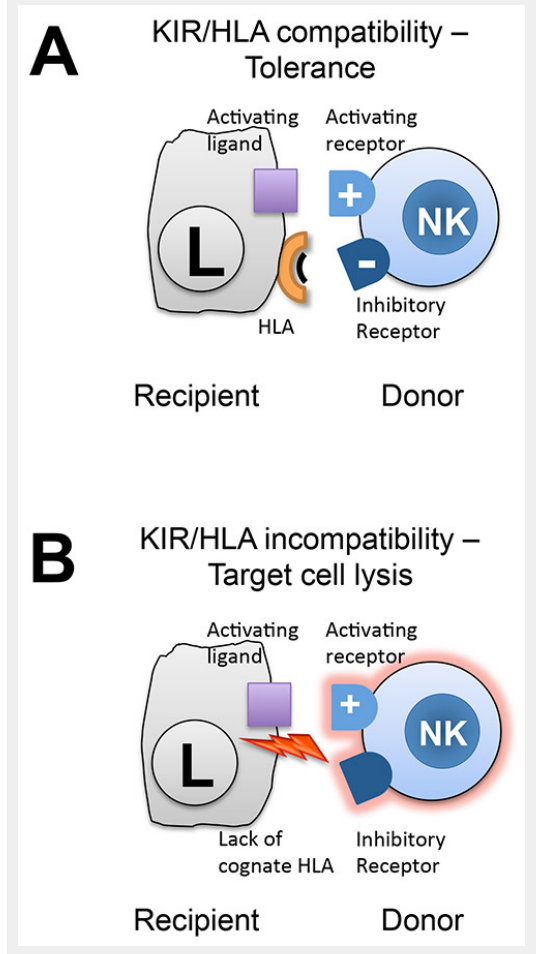
NK cell alloreactivity after haploidentical stem cell transplantation is determined by the HLA class I antigen/KIR constellation of donor and recipient. Donor NK cell activating and inhibitory receptors interact with ligands on recipient target (leukaemia) cells. The activation state of NK cells is determined by the integration of both types of signals. In the case of KIR/HLA compatibility, the inhibitory signal dominates and induces tolerance (panel A). In the absence of a cognate HLA ligand, activating signals dominate and lead to target cell lysis (panel B).